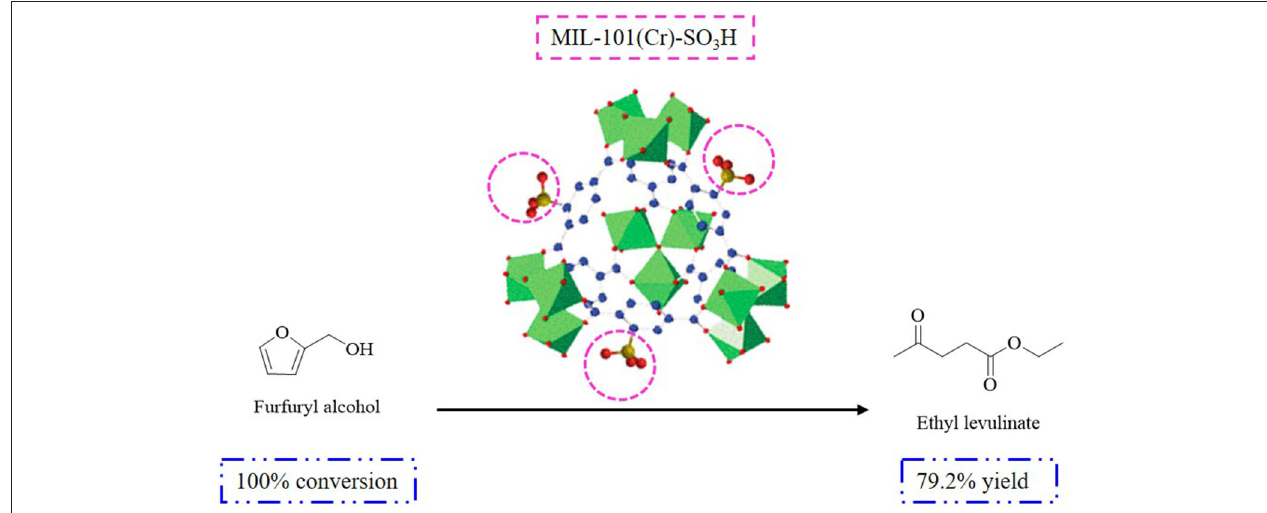
FIGURE 3 | Reaction route for the conversion of FAL to EL over MIL-101(Cr)-SO 3 H.